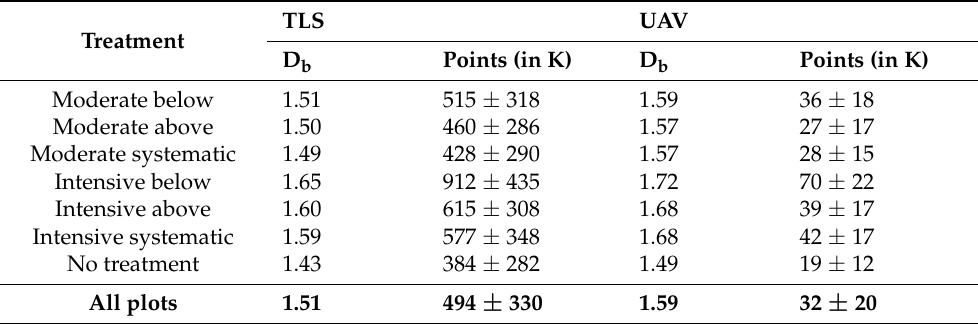
Table 7. Means of terrestrial laser scanning (TLS) and unmanned aerial vehicle (UAV) measured box dimension (D b ) values and average point densities/ tree in thousands (K) (with standard deviations, ± ) within different thinning treatments. TLS D b Points (in K) Points (in K)